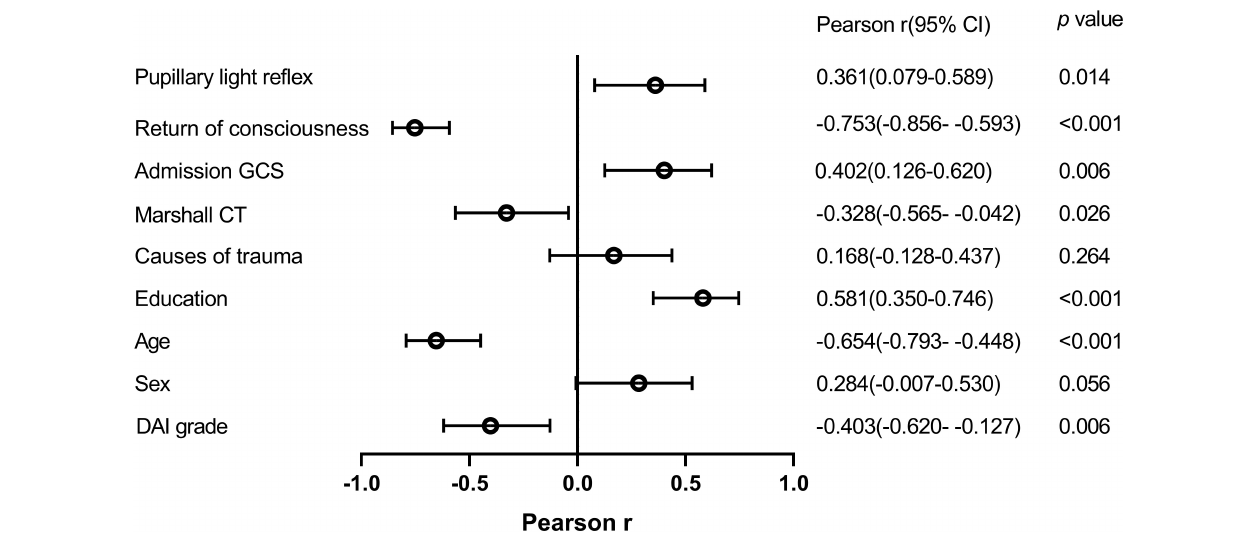
FIGURE2 Relationship between potential risk factors and MoCA-BC scores. MoCA-BC, the Chinese version of the Montreal Cognitive Assessment Basic; GCS, Glasgow Coma Scale.